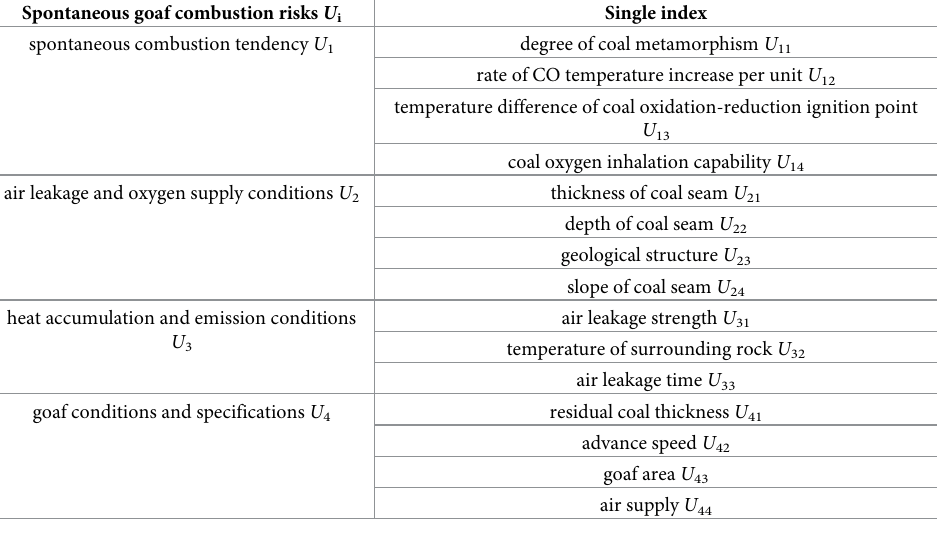
Table 1. Prediction and evaluation system for spontaneous combustion